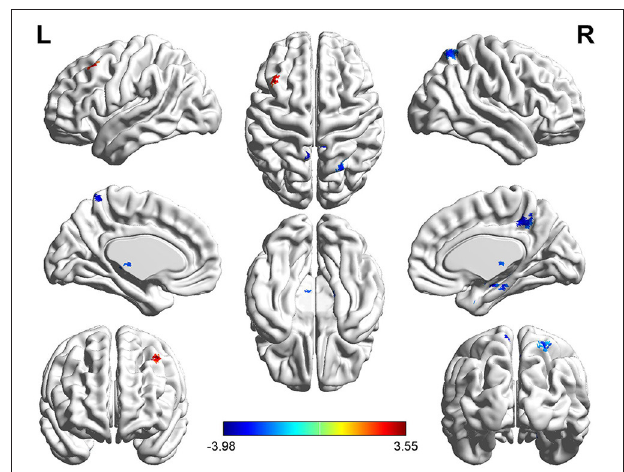
FIGURE 3 | Functional connectivity analysis based on the seed of left SFG between youth-onset schizophrenia and healthy control. The color bar represents T-scores. Warm color represents regions where youth-onset schizophrenia had higher FC, and cold color represents lower FC than HCs. The statistical threshold was set with a combination of voxel-level p < 0.05 and cluster size > 14 mm 3 voxels for left SFG FC analysis (youth-onset drug naïve schizophrenia vs. HCs), TFCE corrected after controlling age, gender, education, and frame-wise displacement. L, left; R,